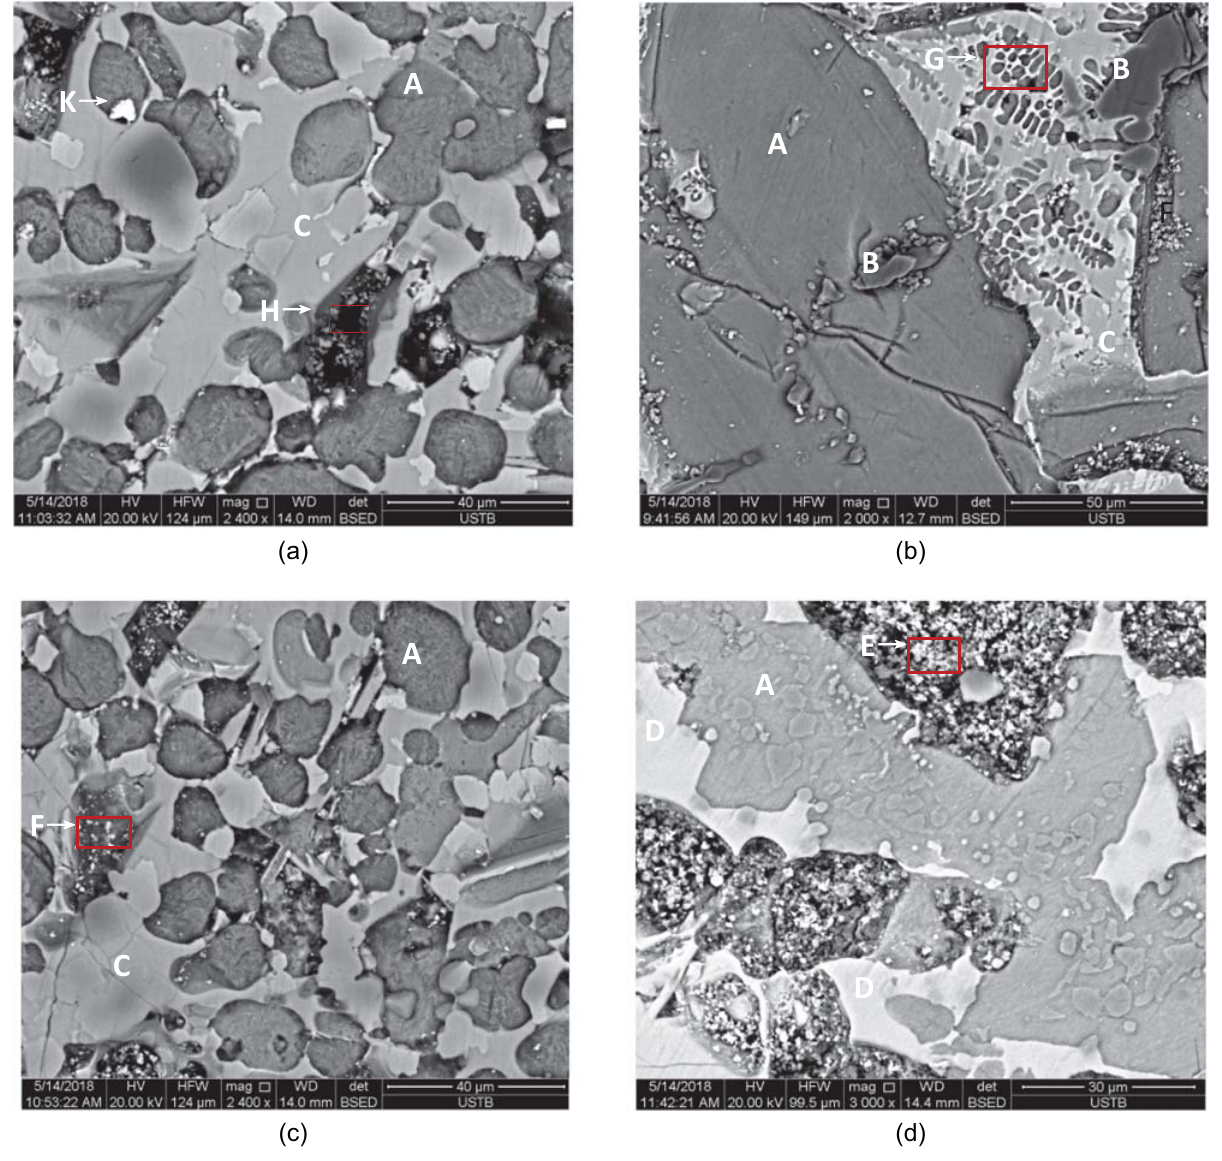
Figure 8: The results of the converter slag detected by SEM. ( a ) SEM image 1, ( b ) SEM image 2, ( c ) SEM image 3, ( d ) SEM image